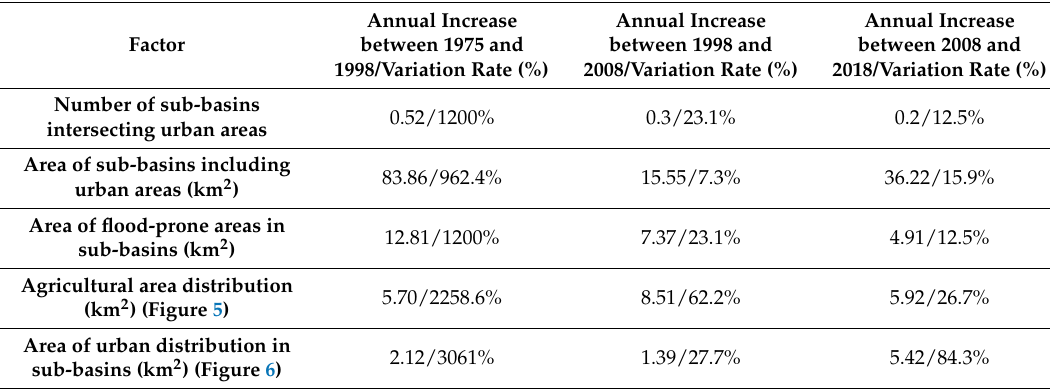
Table 6. Urban and agriculture changes between 1997 and 2018.